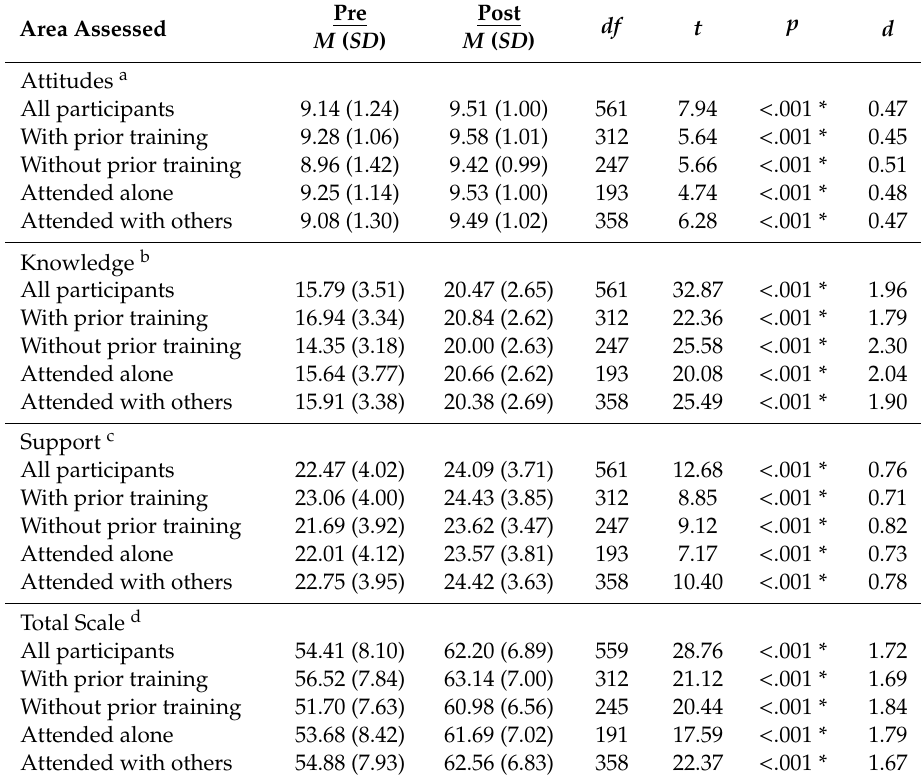
Table 2. CSSS workshop participants’ pre-test and post-test composite scores ( N = 562).